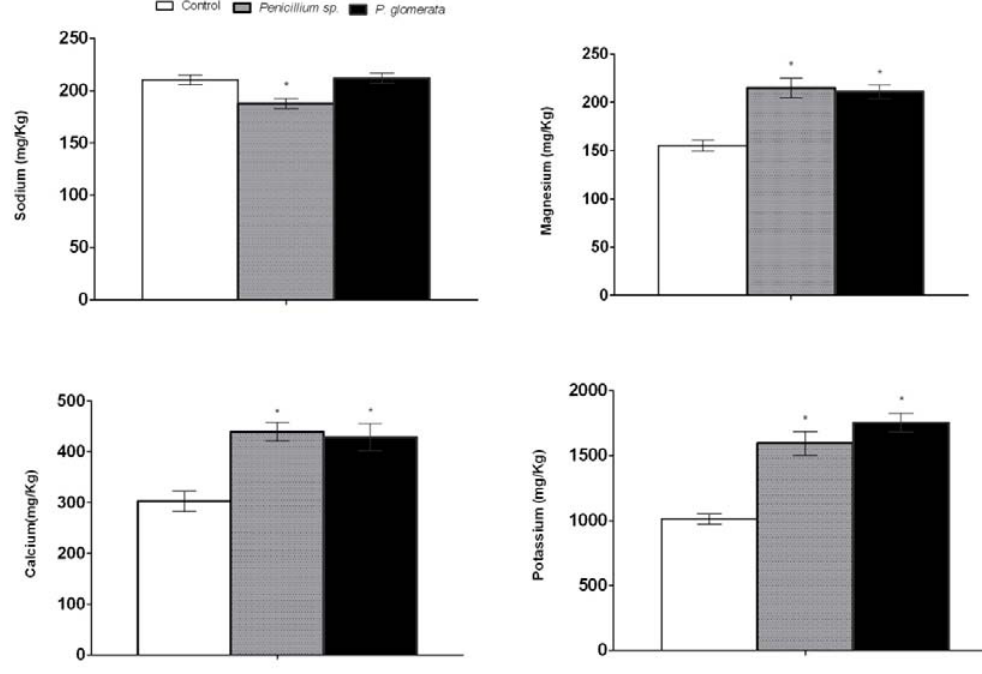
Figure 7. Sodium ion toxicity and essential micronutrient quantification (calcium, magnesium and potassium) of cucumber plants inoculated with or without endophytic fungi ( Penicillium sp. and P. glomerata ) under abiotic stress conditions. Each value is the mean ± SD of three replicates per treatment. The ‘*’ indicates that values are significantly different from control ( p <